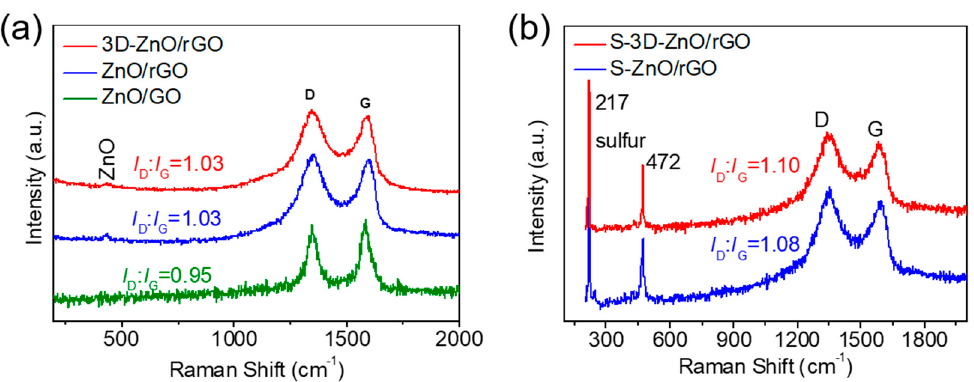
Figure 6. Raman spectra of ( a ) ZnO/GO, ZnO/rGO and 3D-ZnO/rGO composites, ( b ) S-ZnO/rGO and S-3D-ZnO/rGO composites.